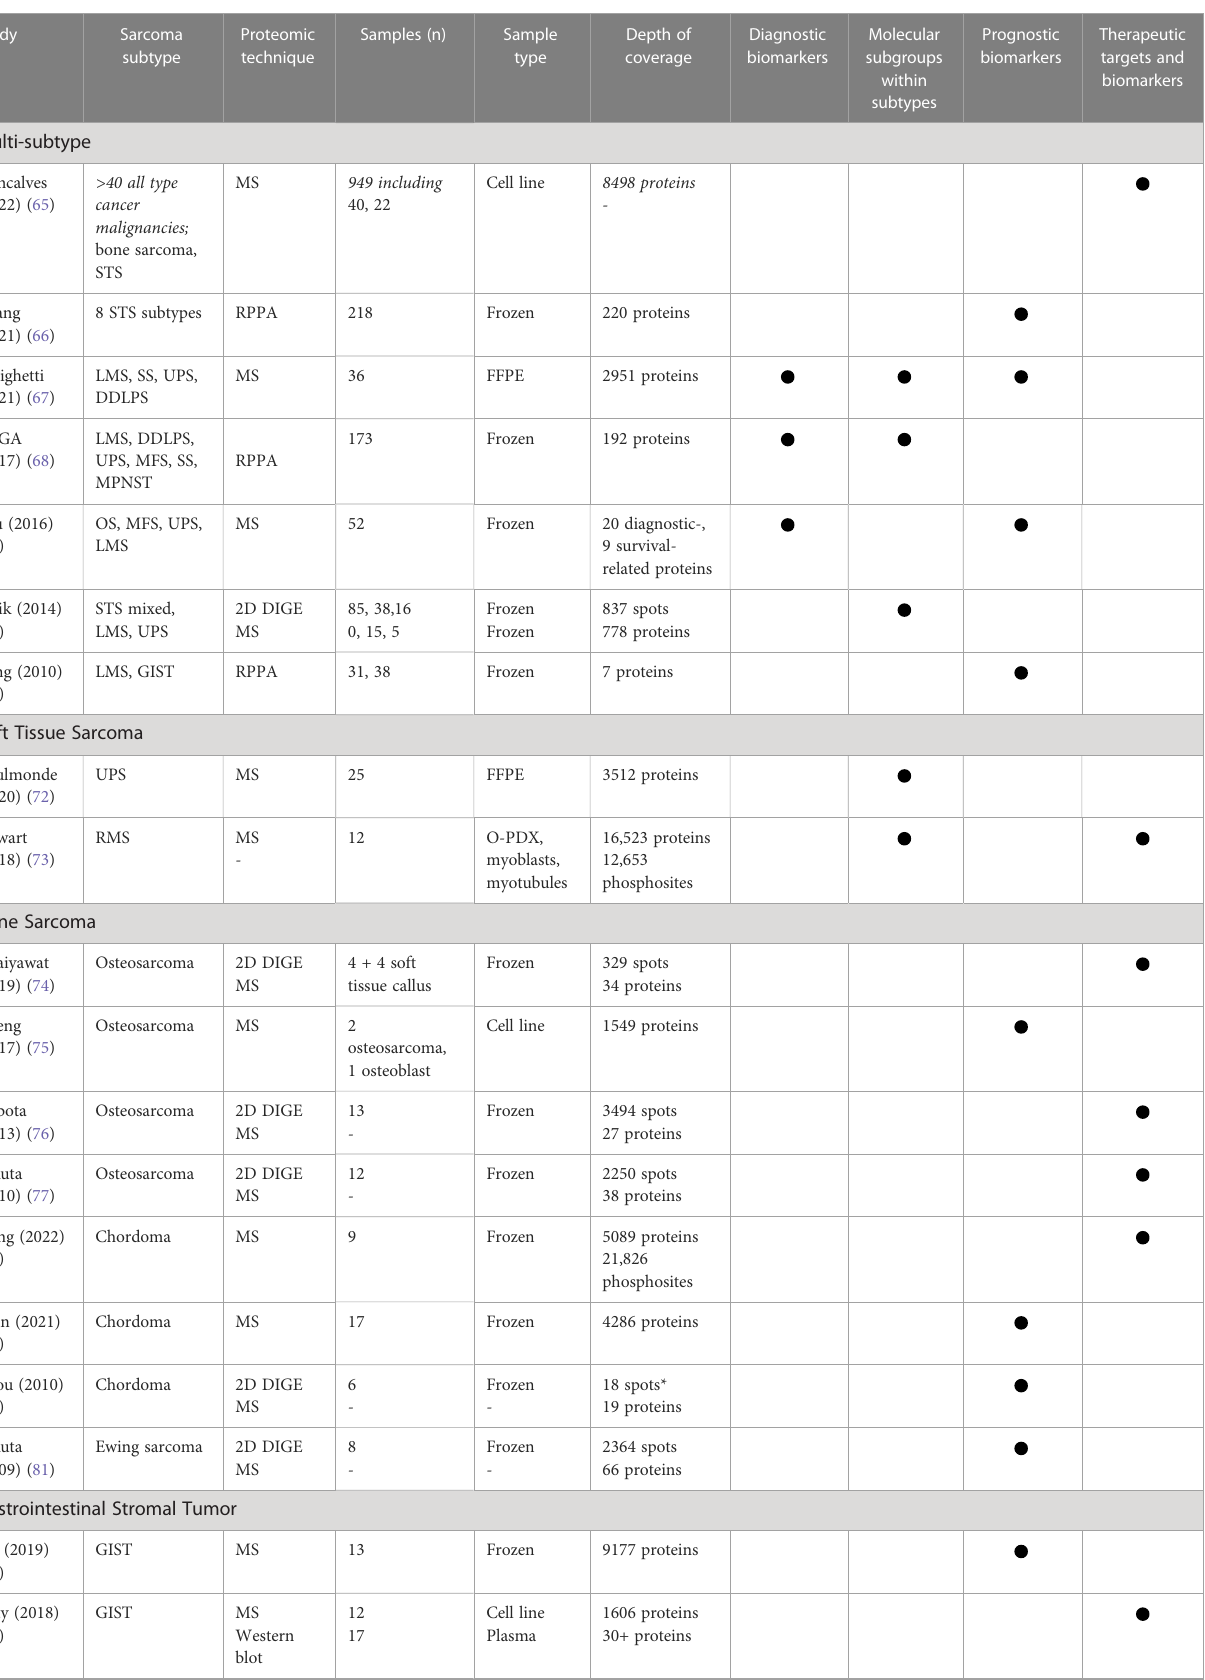
TABLE 1 Summary of quantitative proteomic sarcoma studies with potential clinical